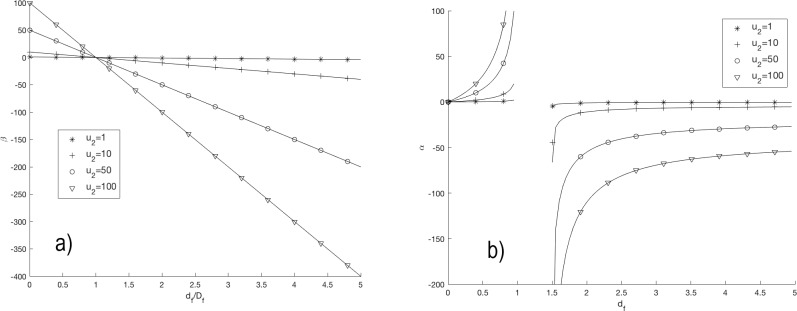
Simulation of Eq (6).For different values of u2 (1, 10, 50 and 100 days-1) it is plotted (A) Graph of α (in days-1) versus df and (B) Graph of β (in days-1) versus df/Df.